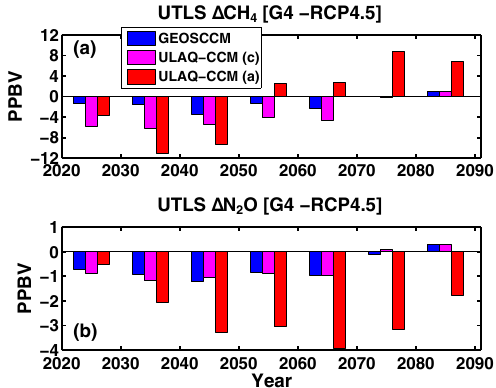
Figure 4. Time series of globally averaged changes of CH 4 (a) and N 2 O (b) in the 50–150hPa vertical layer for GEOSCCM (blue) and ULAQ-CCM (red and magenta, for cases (a) and (c) as in Table 1, respectively) (decadal averages). Units are